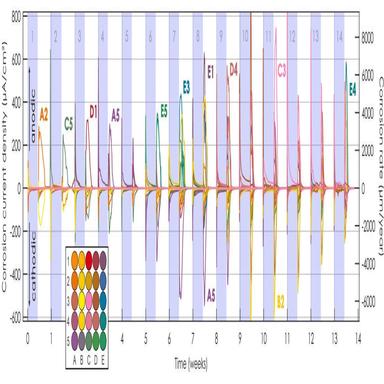
Anodic and cathodic currents for the CEM III specimen over 14 weeks of exposure to cyclic wetting and drying.